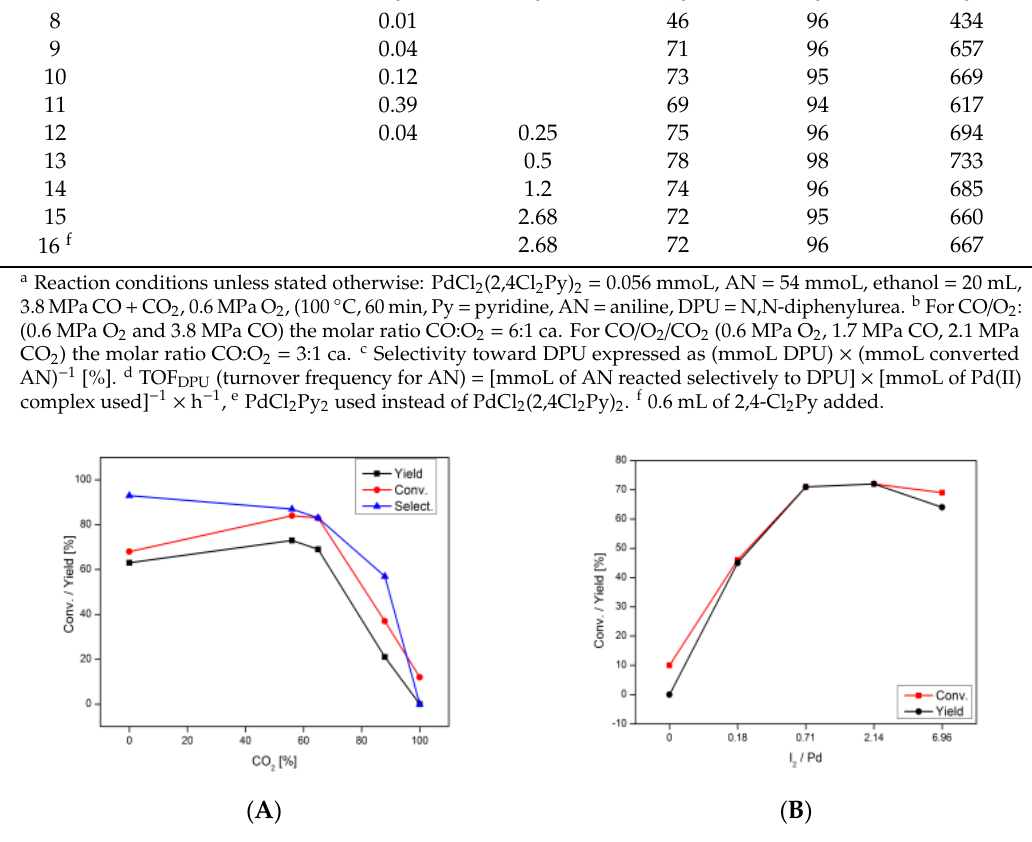
Figure 1. Effect of percentage of CO 2 in CO 2 /CO mixture ( A ) and amount of iodine ( B ) on the conversion (Conv.) and yield and selectivity (Select.) of the catalyst. For the reaction conditions see footnotes in Table 1. Table 1. Parameters obtained for the carbonylation a of aniline with CO/CO 2 /O 2 mixture, catalyzed by Pd(II) complexes: conversion (C AN ), selectivity (S DPU ) and turnover frequency (TOF DPU ) of the catalyst, depending on the contents of CO 2 in CO 2 /CO, iodine, and iron